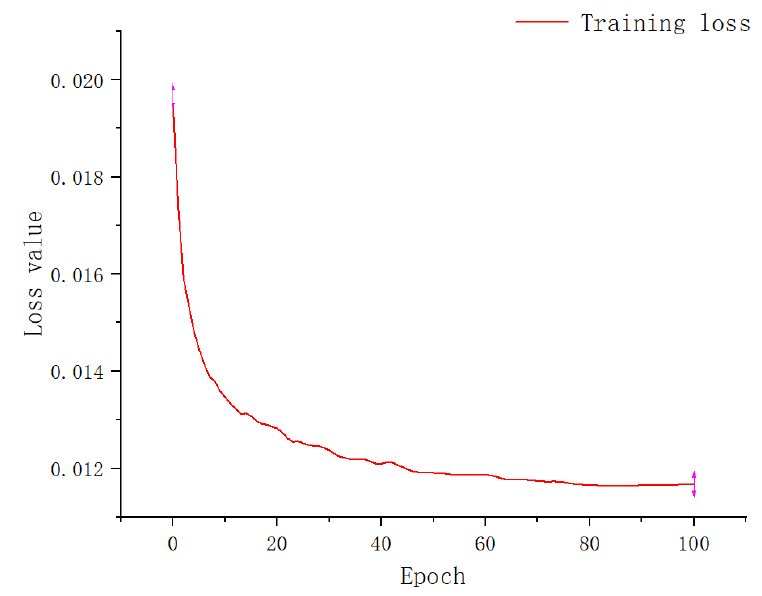
Figure 9. Training loss curve.